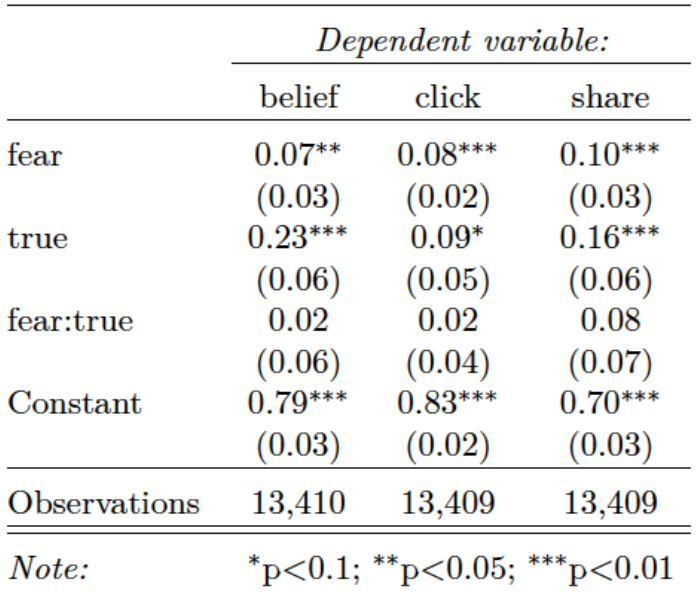
Table B6. Association between sad and belief, click, and